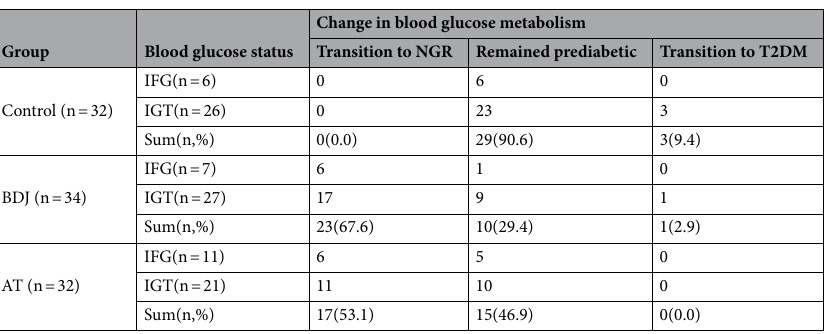
Change in blood glucose metabolism Group Blood glucose status Transition to NGR Remained prediabetic Transition to